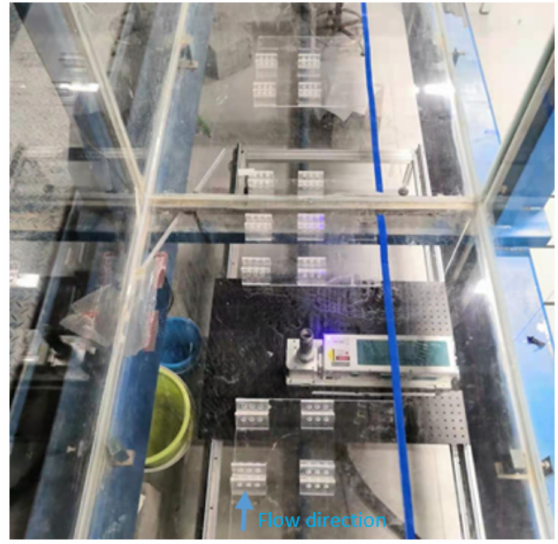
Figure 3. Aerial view of the artificial reefs placement.